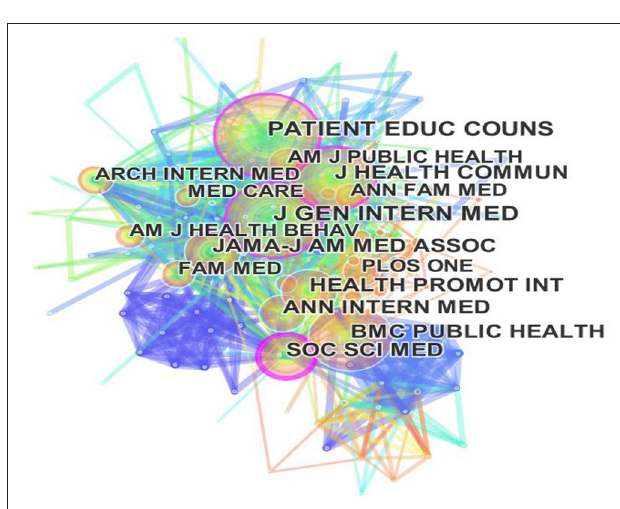
FIGURE 2 | Visualization on main research journals in health literacy